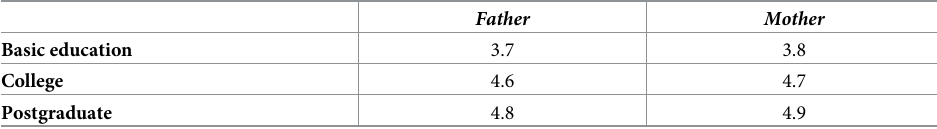
Table 5. Understanding of ET by level of education of a parent.